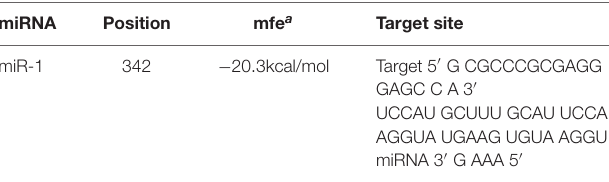
a Minimum free energy (mfe) values based on RNAhybrid 2.2 prediction.